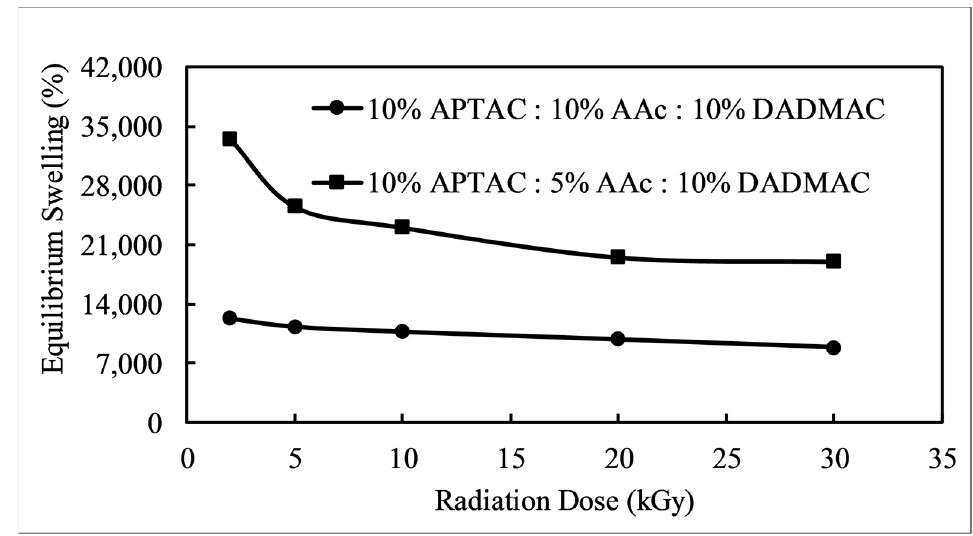
Figure 2. The effect of gamma radiation dose on equilibrium swelling of the hydrogel at room temperature.